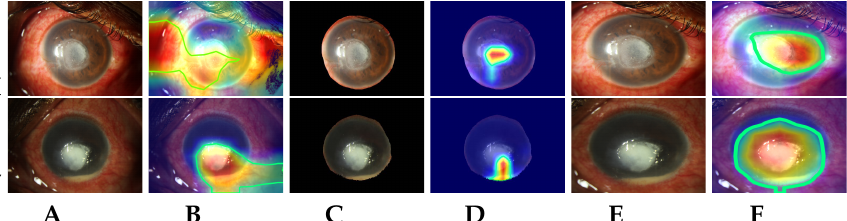
Figure 6. Sample Grad-CAM visualizations generated by the proposed model for correctly identified FK images. ( A ) Original keratitis images (source: [12]); ( B ) Grad-CAM visualizations for ( A ) images; ( C ) Automatic segmented corneal images in ( A ) using MS-CNN; ( D ) Grad-CAM visualizations for ( C ) images; ( E ) Automatic RoI cropped images in ( A ) using MS-CNN; ( F ) Grad-CAM visualizations for ( E )